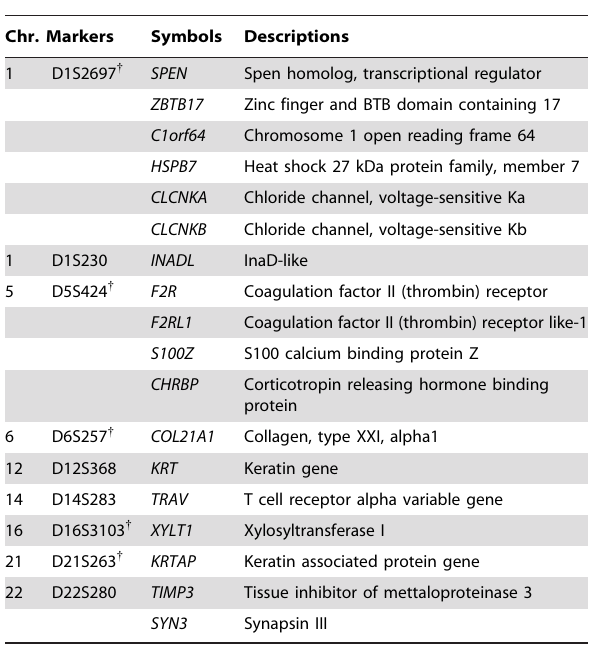
Table 2. Candidate genes located around 100 kb from each significant marker shown in Table